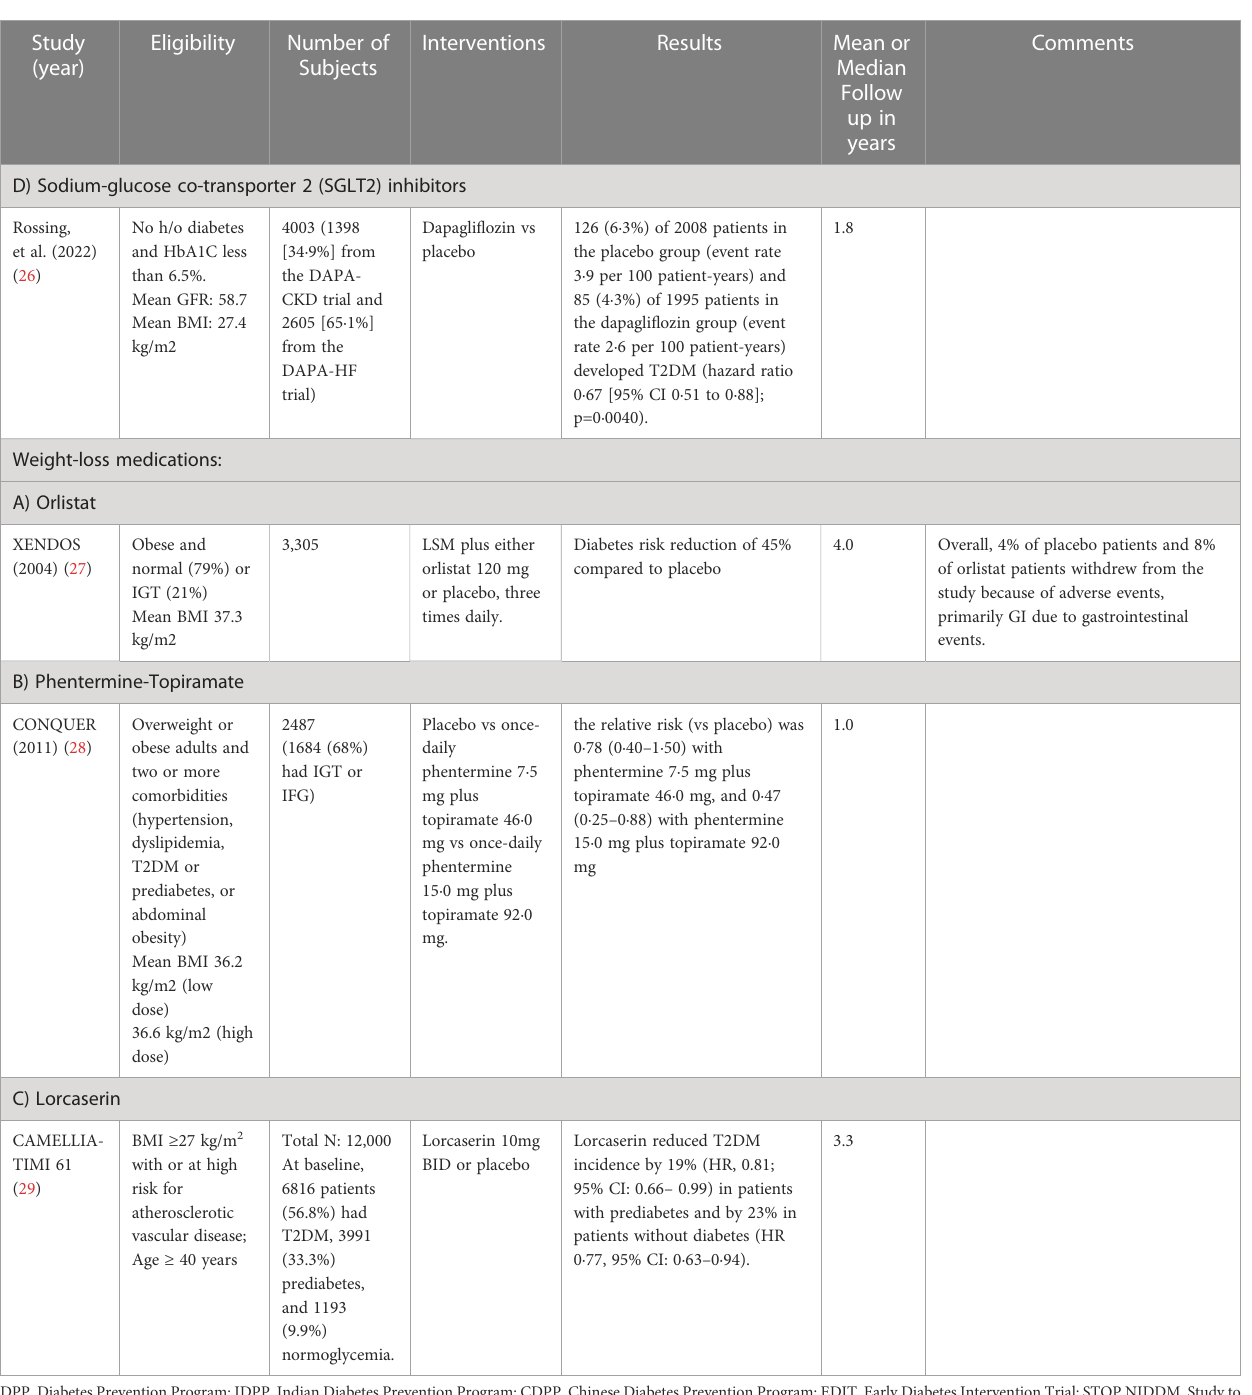
average rate of diabetes of 4.6% per year during treatment with pioglitazone for three years, which was much lower compared with the rate of 12.1% per year that was observed during placebo treatment in the TRIPOD